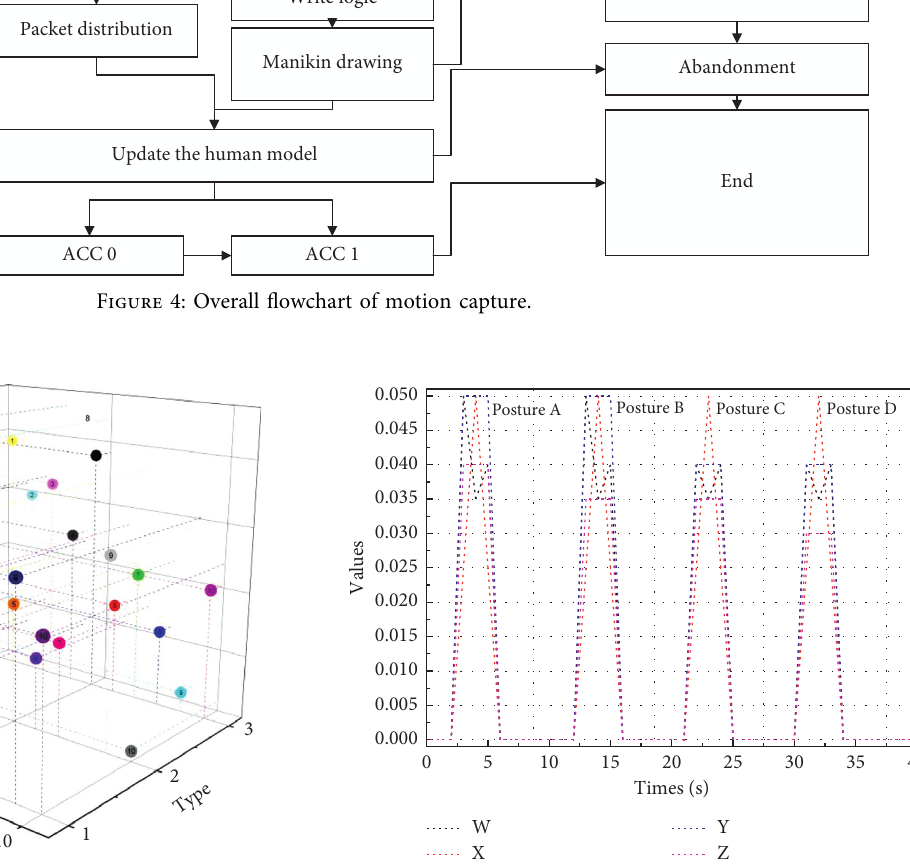
Figure 5: System delay test results. Figure